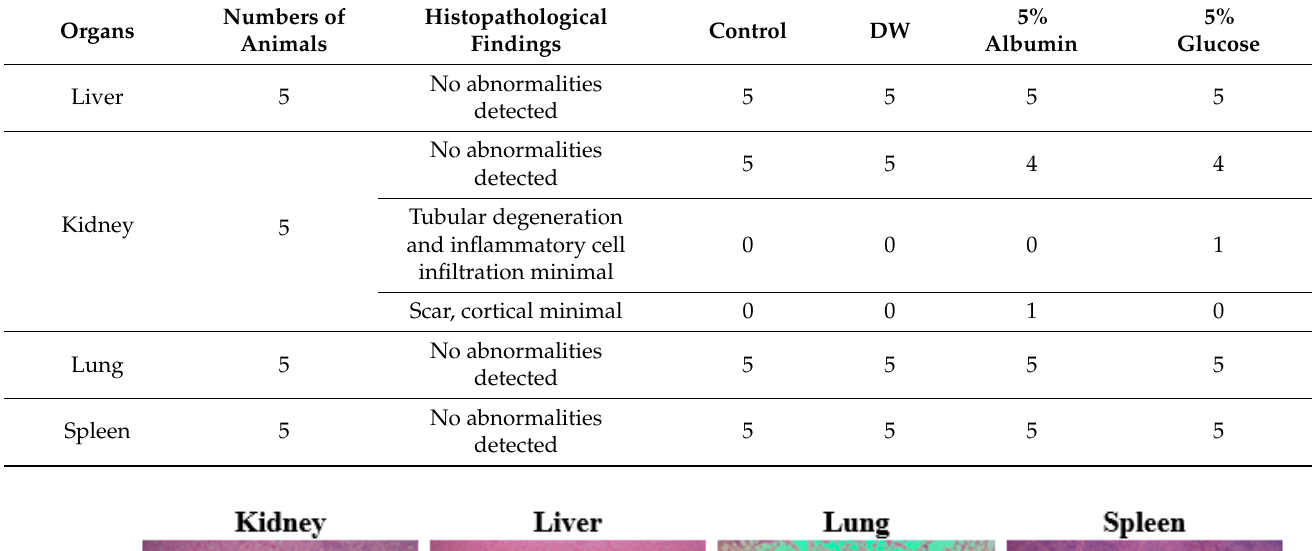
Table 5. Summary of histopathological findings of rats after oral administration of ZnO NPs (100 mg/kg) interacted with DW, albumin, or glucose for 14 consecutive days.